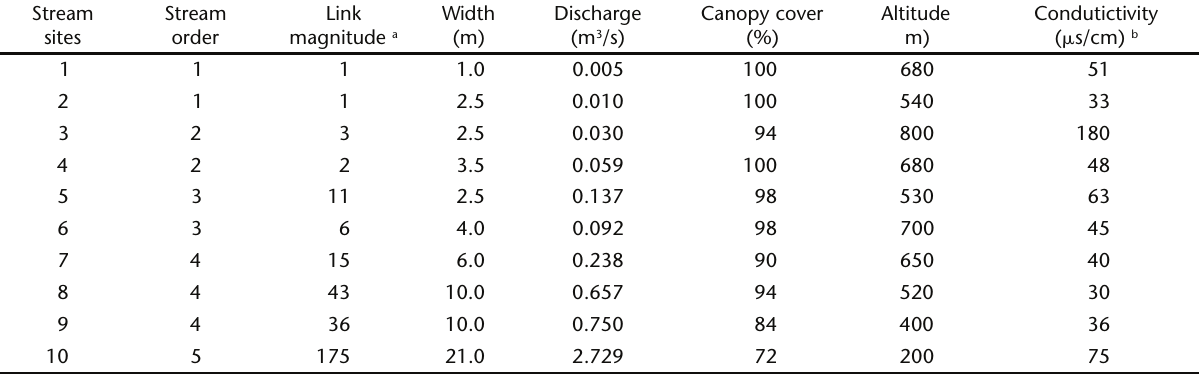
Table I. Physical characteristics of the 10 sampling sites in Parque Estadual Intervales. a Number of first order streams included in the subcatchment; b Obtained using a Presto-Tek (California, USA) conductivimeter.